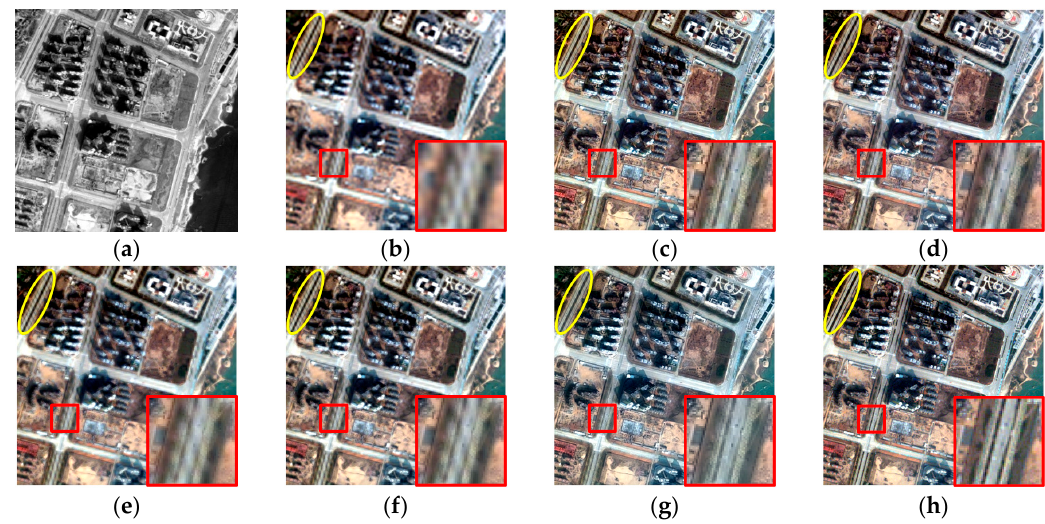
Figure 5. Fusion results of the QuickBird experiment. ( a ) PAN image; ( b ) MS image; ( c ) GS fusion result; ( d ) PCA fusion result; ( e ) AIHS fusion result; ( f ) AWLP fusion result; ( g ) proposed fusion result; ( h ) original MS image.